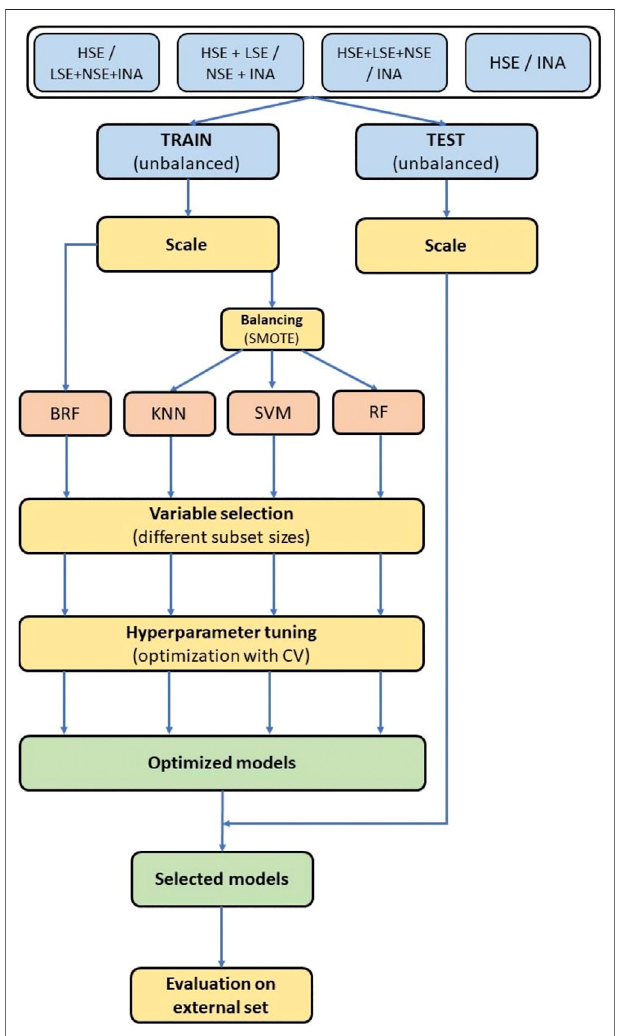
FIGURE 3 | Modelling work fl ow. Colors of the blocks are related to different phases of the modelling procedure. Light blue blocks: data preparation. Light red block: machine learning. Yellow blocks: data selection and optimization. Green blocks: models selection.